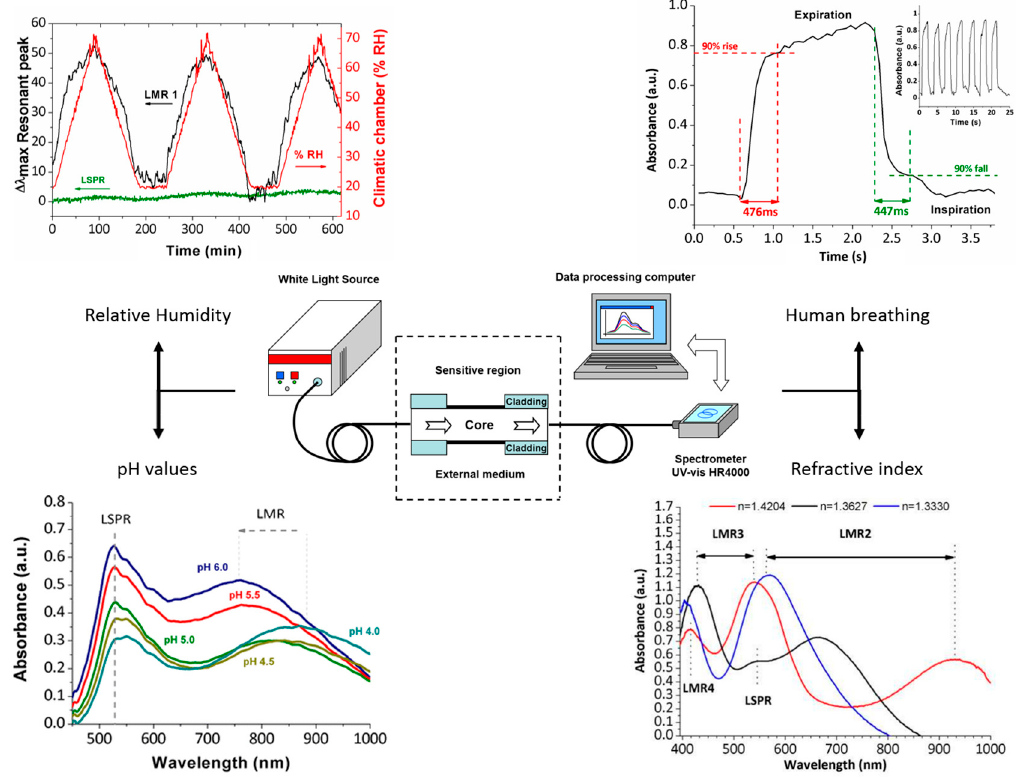
Figure 19. Experimental setup used for the design of dual LSPR-LMR optical fiber devices for sensing applications and the difference in their corresponding sensitivities in real cases for monitoring the Relative Humidity (RH), pH changes, human breathing and refractive index values.